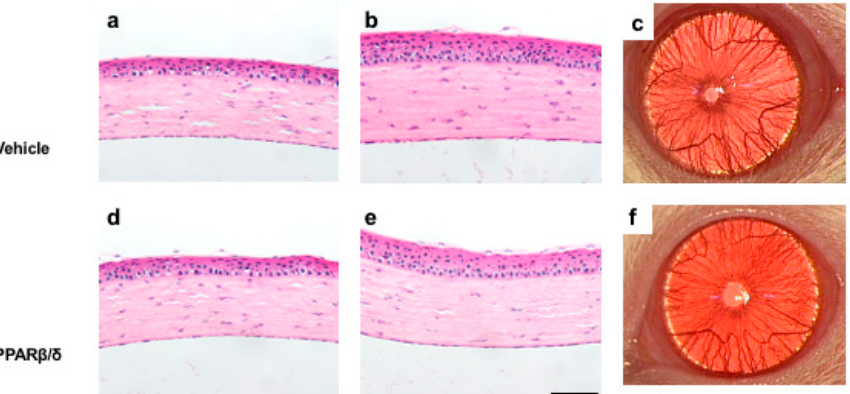
Figure 8. Effect of the PPAR β / δ agonist on the normal cornea at 7 days. HE staining of the vehicle group ( a : central region, b : peripheral region) and PPAR β / δ group ( d : central region, e : peripheral region). Bar, 50 μ m. No obvious difference in the HE staining images or macroscopic images ( c , f ) was apparent between the two groups.